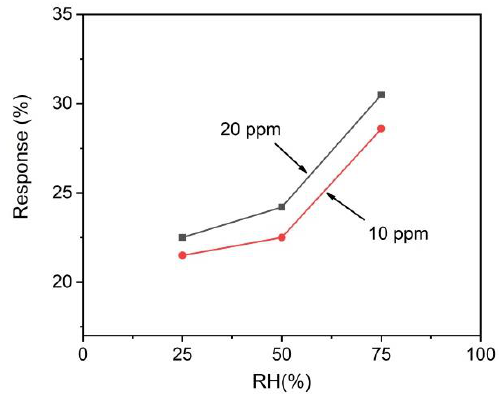
Figure 12. Response of the S2 sample at 100 °C to 10 ppm and 20 ppm NO 2 with the changing relative humidity of water vapor in air.